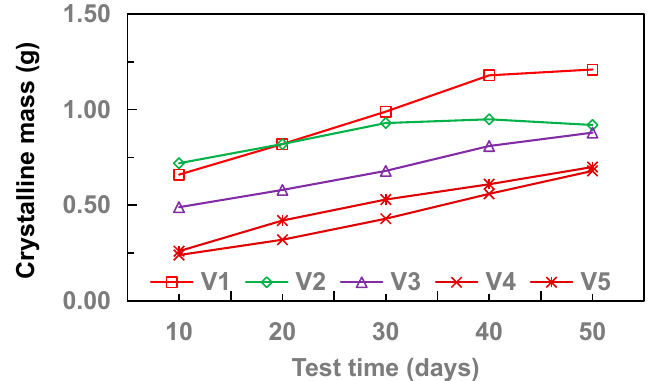
Figure 7. Variation of crystal quality with time.